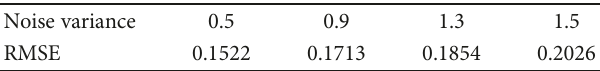
Figure 6: The result provided by CEEMDAN for simulation signal analysis. Table 1: The proposed algorithm in signal